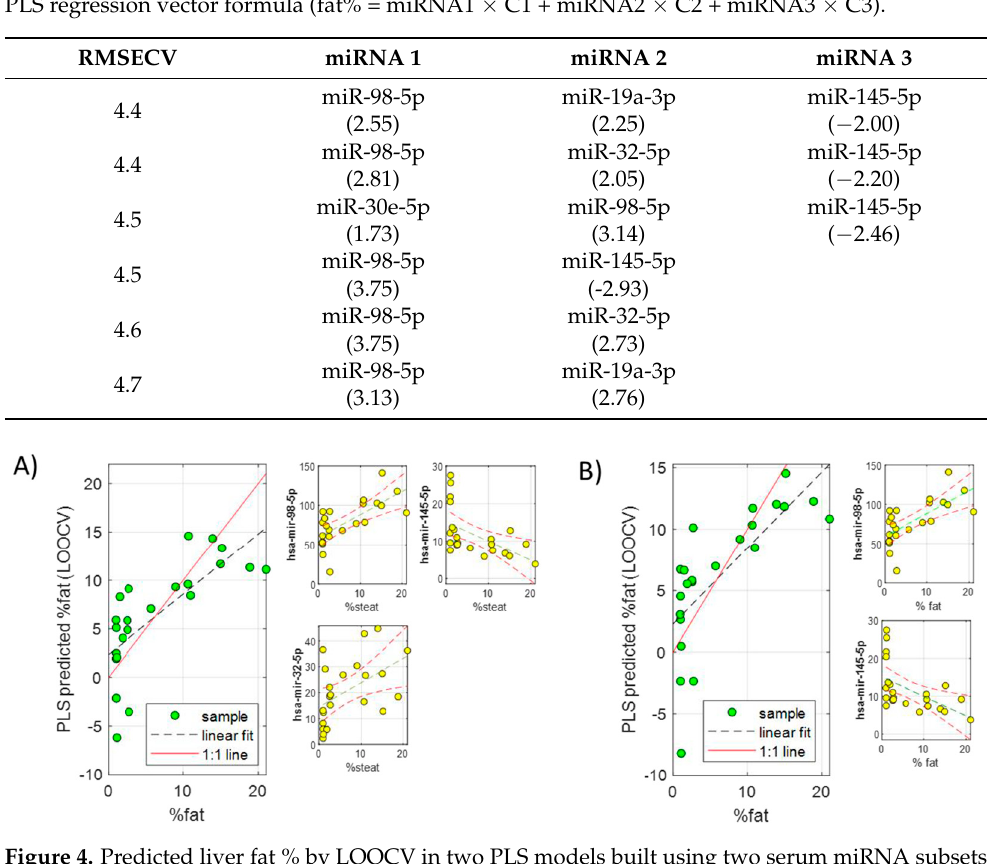
Table 2. Best serum miRNA combinations predicting fat % with an error <5% of fat. Values in parentheses correspond to the coefficients (autoscaled intensities, C1, C2, C3) in the corresponding